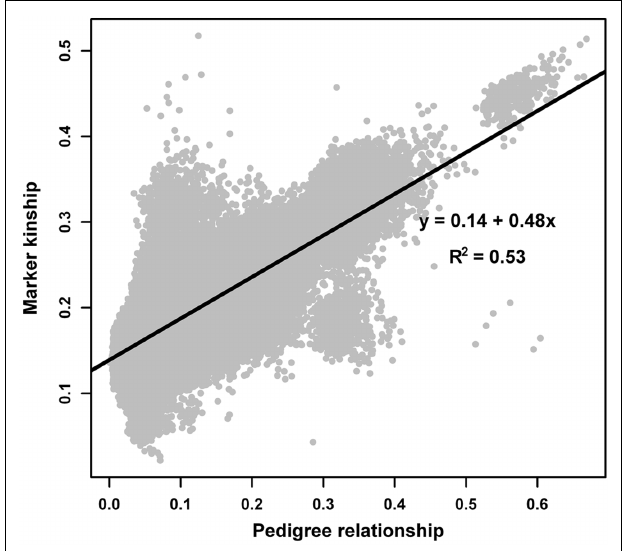
FIGURE 1 | Kinship coefficients estimated from marker data against relationship coefficients estimated from pedigree data.